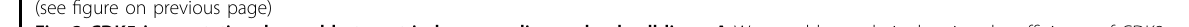
Fig. 3 CDK5 is a putative druggable target in human salivary gland cell lines. A Western blot analysis showing the ef fi ciency of CDK2 knockdown (KD) with four different shRNA hairpins in LWM-E expressing A1 cell lines. Numbers indicate the % KD, quantitated using ImageJ and normalized to the loading control β -actin. B Mass spectrometry results indicating the number of unique peptides of CDK5 bound to LMW-E in A1 cell lines, stably transfected with either shScramble (shSCR) or two different hairpins of shCDK2. C IP/western blots analysis assessing the binding of CDK2 and CDK5 in A1-LMW-E cell lines (from Panel A ), with and without stable knockdown of CDK2. Brie fl y, 400 μ g of protein from each cell line were subjected to IP with anti-cyclin E (1 μ g antibody per 500 μ g protein) overnight, followed by western blot analysis of the indicated proteins. D , H Isogenic HSG cell lines (A1, A5, clones 9 and 10) and A1 isogenic cell lines ( − / + shCDK2 knockdown) were transfected with either 50 nM of SCR